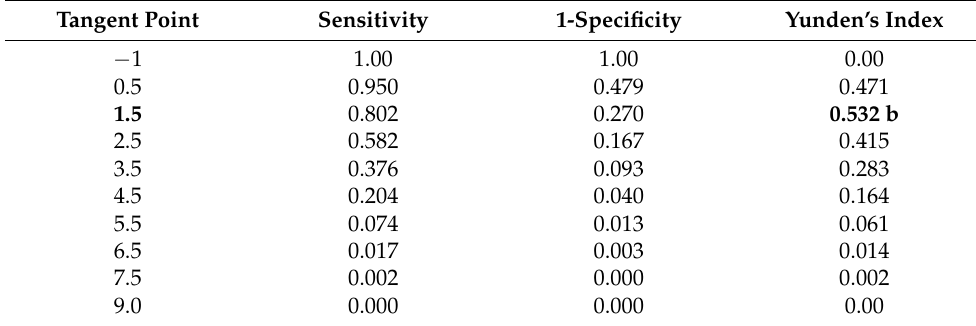
Table 2. The Best Tangent Point for Fall Risk Factor Assessment Scale Score.